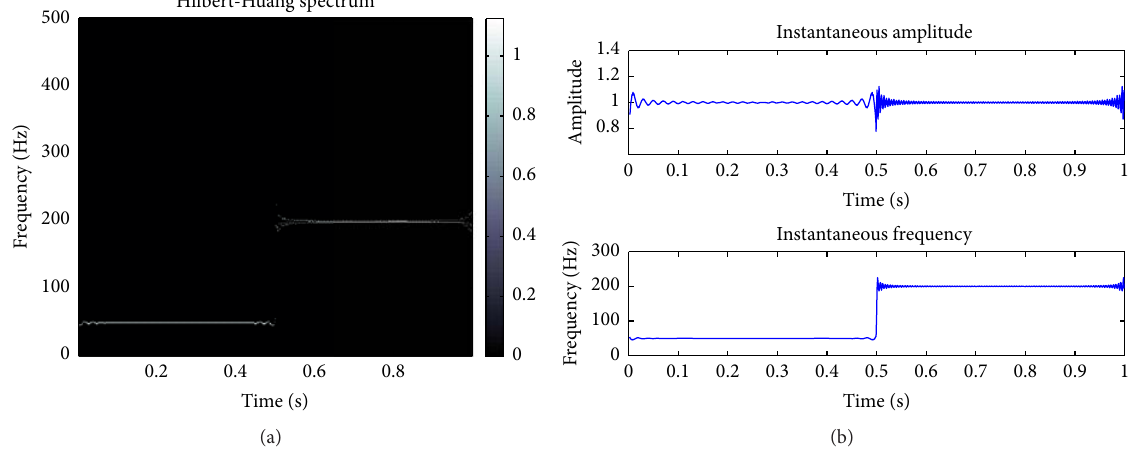
Figure 5: (a) The result of Hilbert spectrum. (b) The instantaneous amplitude and the instantaneous frequency.